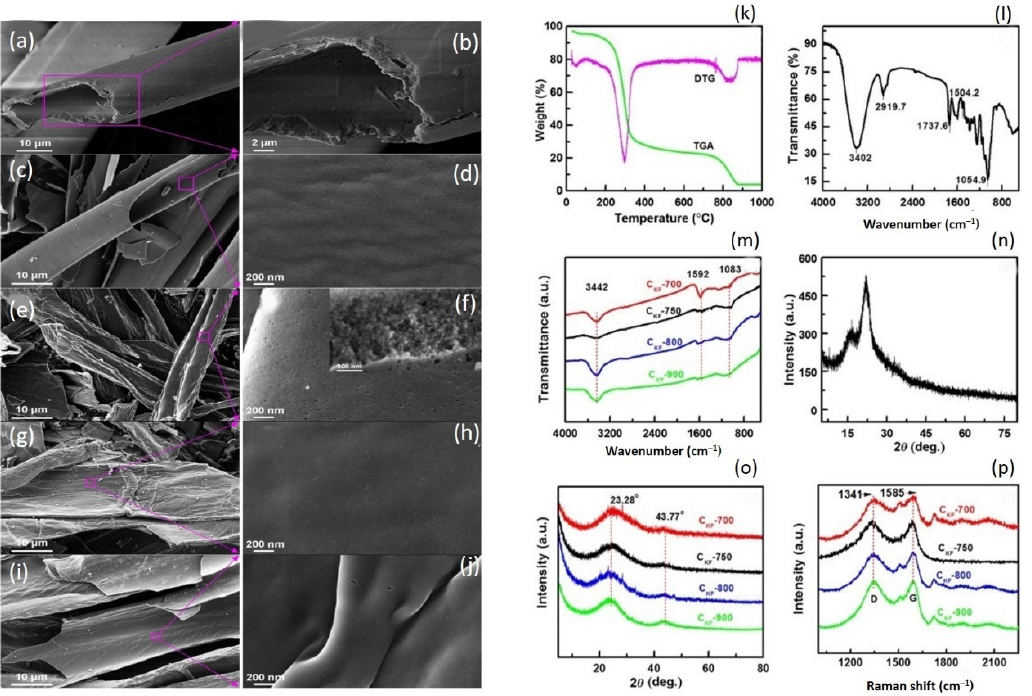
Figure 9. FE-SEM scans of the KF ( a , b ), CKF-700 ( c , d ), CKF-750 ( e , f ), CKF-800 ( g , h ), and CKF-900 ( i , j ). TGA and DTG curves of natural KF ( k ), FT-IR spectra of natural KF ( l ) and biochars ( m ), XRD patterns of natural KF ( n ) and pyrolysis KF ( o ), and ( p ) pyrolysis KF Raman spectra. Reprinted with permission from Ref. [90]. Copyright 2018, copyright Elsevier.